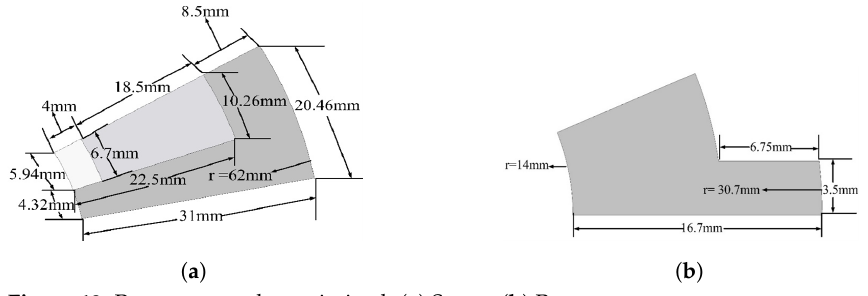
Figure 13. Parameters to be optimized. ( a ) Stator. ( b ) Rotor.